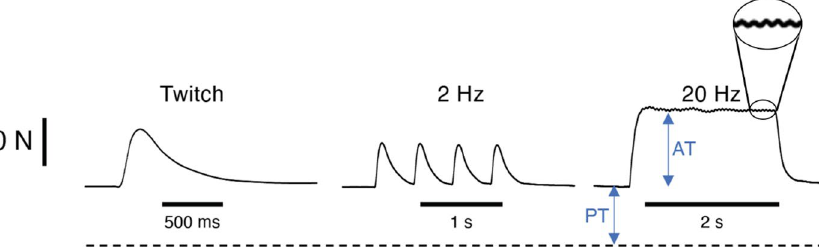
Figure 14. Intraoperative contractile record from BFT of gracilis muscle. Active tension (AT) and Passive tension (PT) are indicated in the figure. The dotted line represents zero tension, so this muscle is under about 20 N of passive tension in vivo. Inset represents the plateau of the 20 Hz stimulation showing a 20 Hz